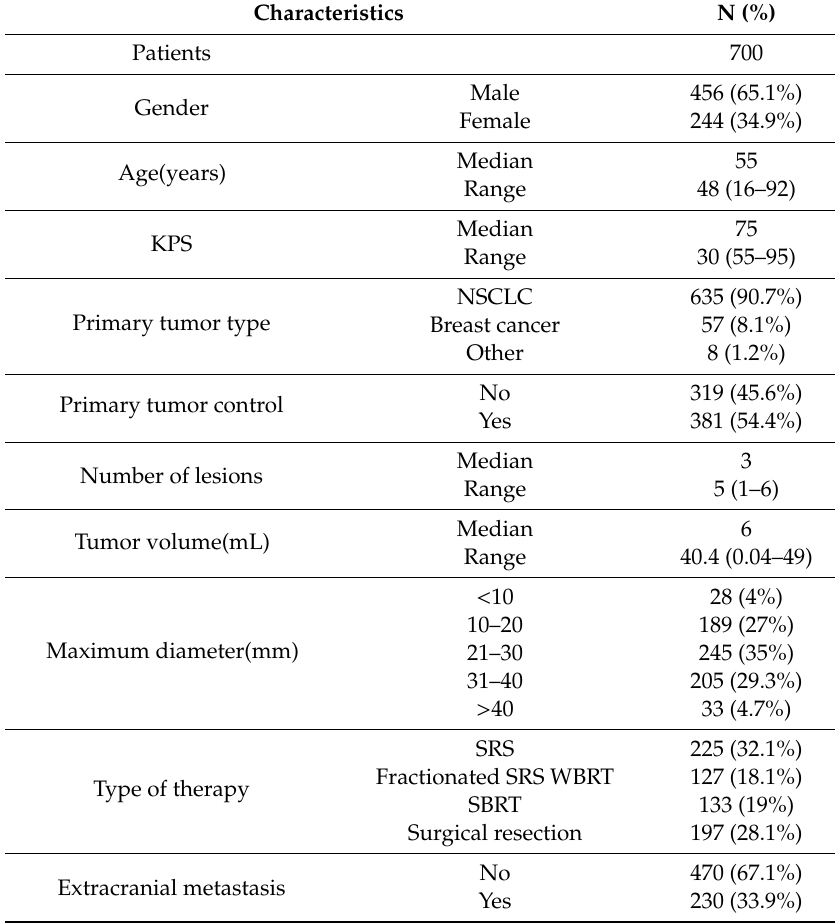
Table 5. The characteristics and demographics of the